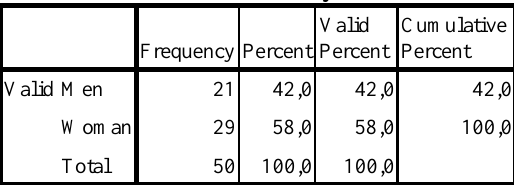
Table 3. Distribution by Gender